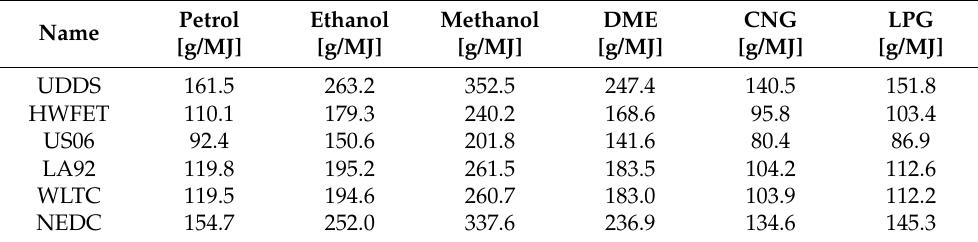
Table 8. Summary of the final consumption of tested fuels per 1 MJ obtained from the simulations of the 2018 Toyota Camry LE vehicle for selected road tests.